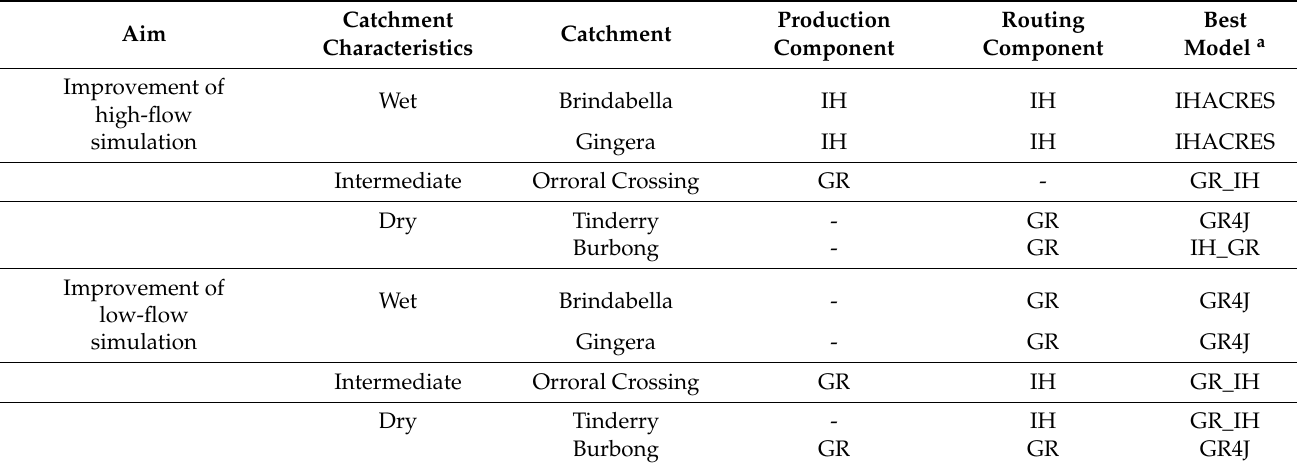
Table 3. The components of the GR4J and IHACRES models that improve the original IHACRES or GR4J model perfor- mances with respect to the aim of the simulation and the characteristics of the catchments. Production Routing Catchment Catchment Aim Component Component Model a Characteristics Improvement of